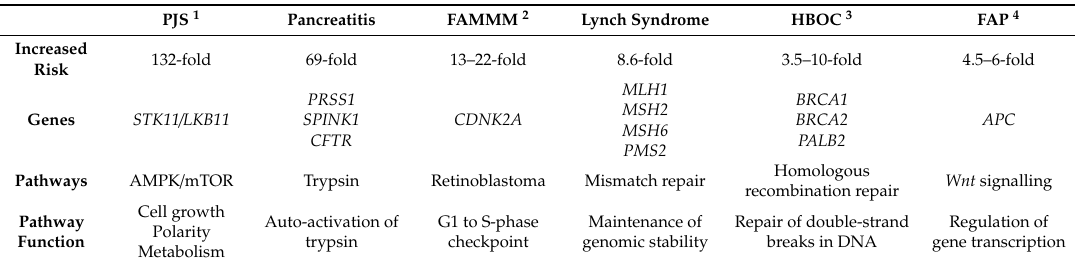
Table 1. Familial Cancer Syndromes associated with an increased risk of developing pancreatic ductal adenocarcinoma (PDAC). The table includes increased risk, genes associated with syndrome / disease, pathways associated with syndrome / disease and pathway